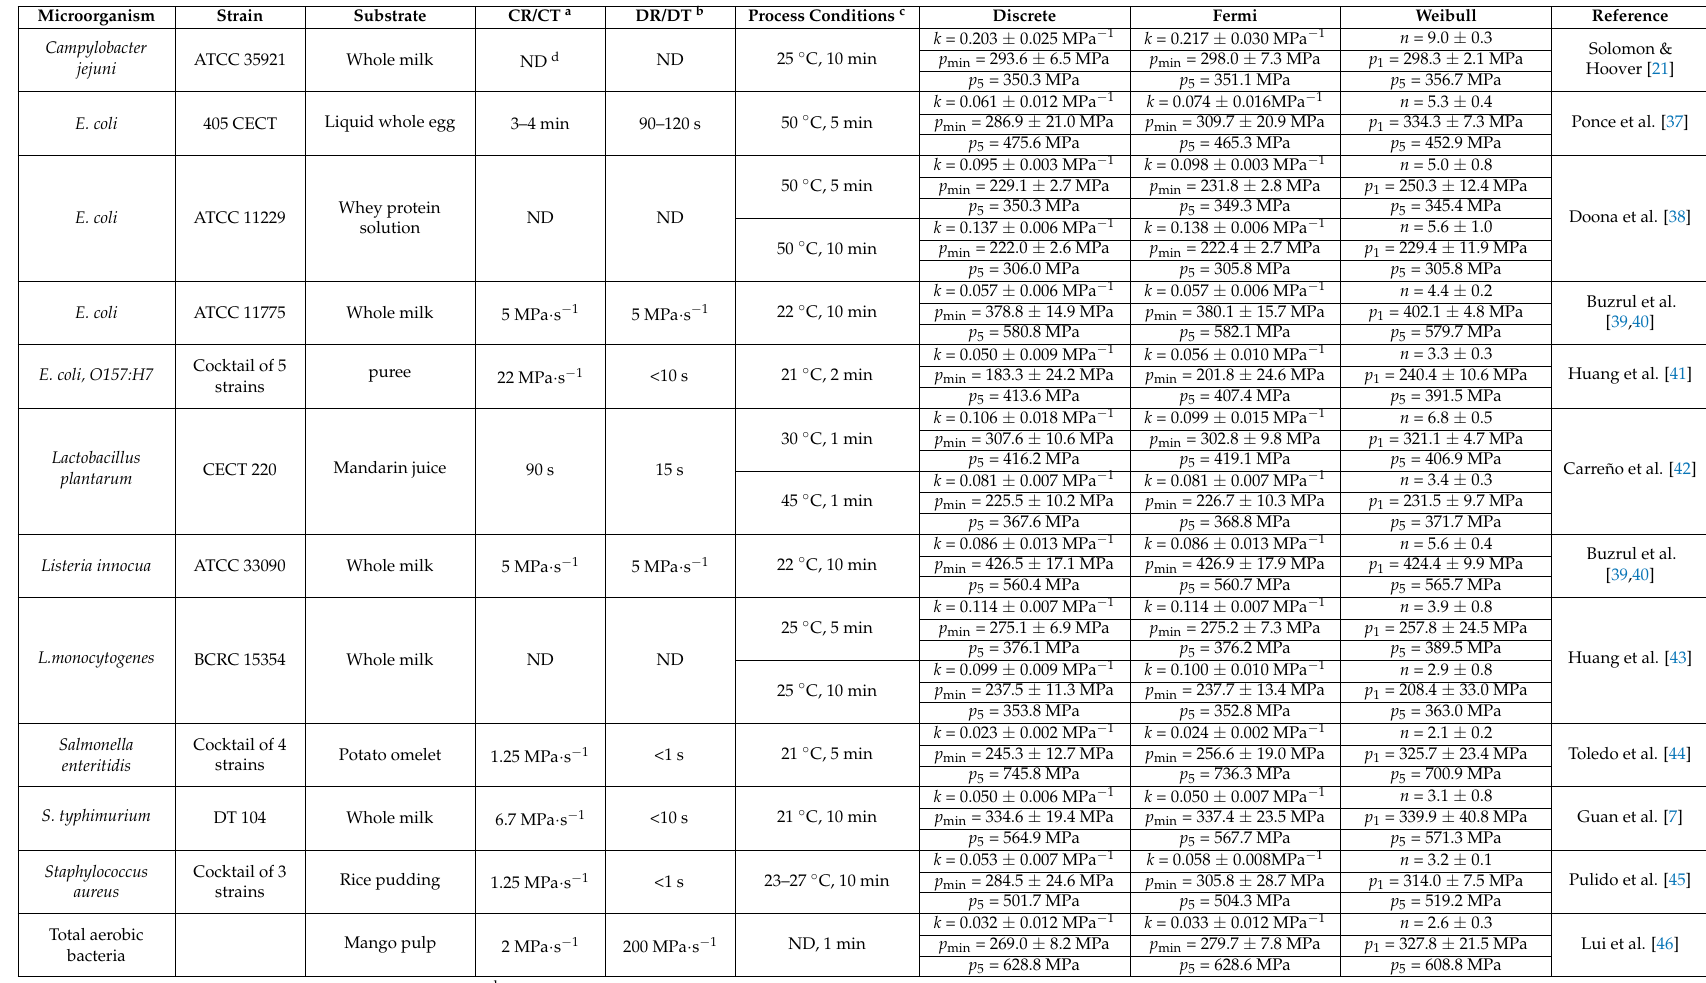
Table 3. Parameters and P 5 values of the Discrete, Fermi, and Weibull models applied to microorganisms exposed to high hydrostatic pressure (HHP) in foods.